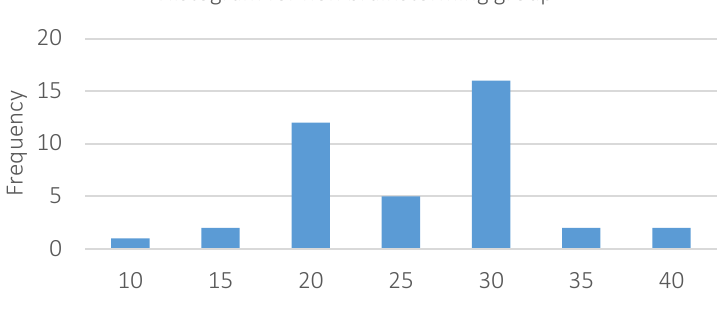
Figure 4. Normality histogram (brainstorming group) Table 6. Normality test